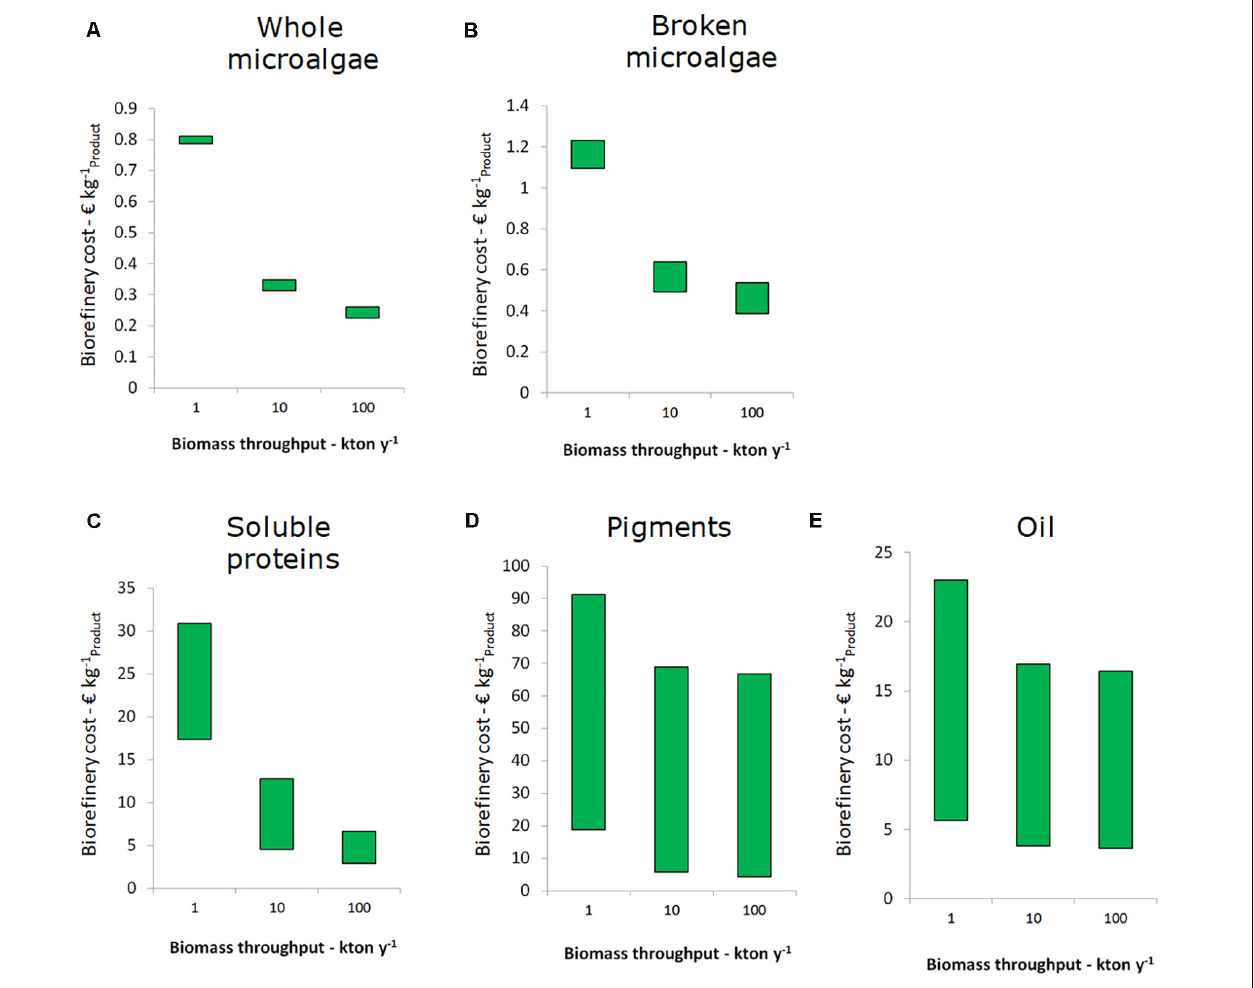
FIGURE 4 | Effect of processing scale on the biorefinery costs (excluding cultivation) for the single product value chain, per unit of main product. (A) Whole microalgae, (B) Broken microalgae, (C) Soluble proteins, (D) Pigments, and (E) Oil. The bars indicate the range of costs, which is species dependent.